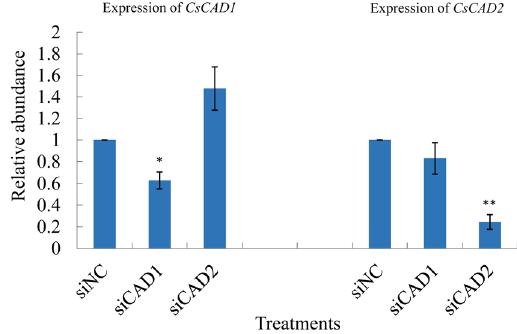
Figure 4. Relative expression of the Chilo suppressalis cadherin genes CsCAD1 and CsCAD2 24 hrs after siRNA treatment. Results are means ± SE. Bars with the same lowercase letter are not significantly different; NC = negative control, si CAD1 = CsCAD1 knockdown treatment group, si CAD2 = CsCAD2 knockdown treatment